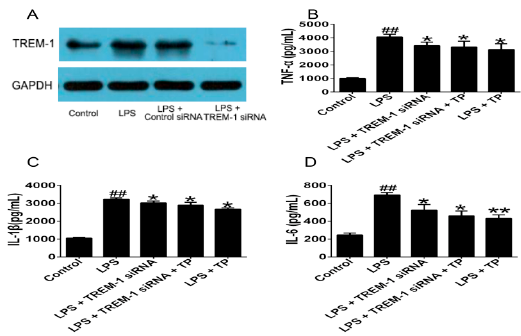
Figure 4. Effects of TP on inflammatory cytokines expression after TREM-1 knockdown. PMA-induced U937 cells were treated with or without 1 µ g/mL LPS, and then transfected with TREM-1 siRNA or control siRNA, respectively. After 48 h, cells were treated with or without TP for another 48 h. ( A ) TREM-1 mRNA protein levels were determined by Western blot; and ( B – D ) TNF- α , IL-1 β and IL-6 production were determined by ELISA. ## p < 0.01 versus the control group; * p < 0.05 and ** p < 0.01 versus the group with LPS. The data are presented as the means ˘ standard deviation from three independent